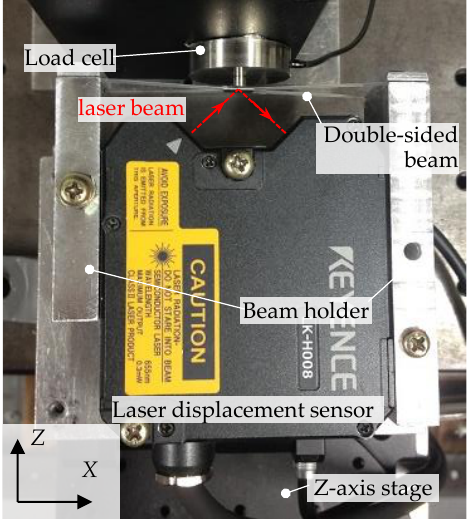
Figure 5. Experimental setup for evaluation of the spring constant.